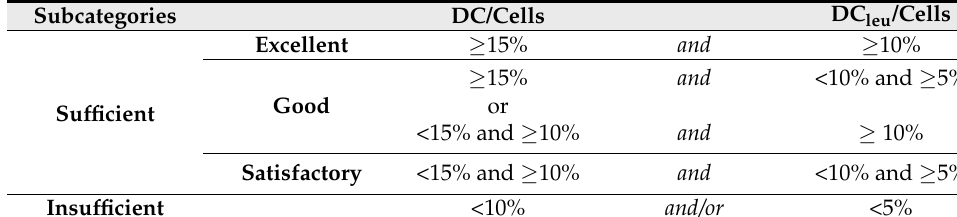
Table 1. Classification of DC- and DC leu